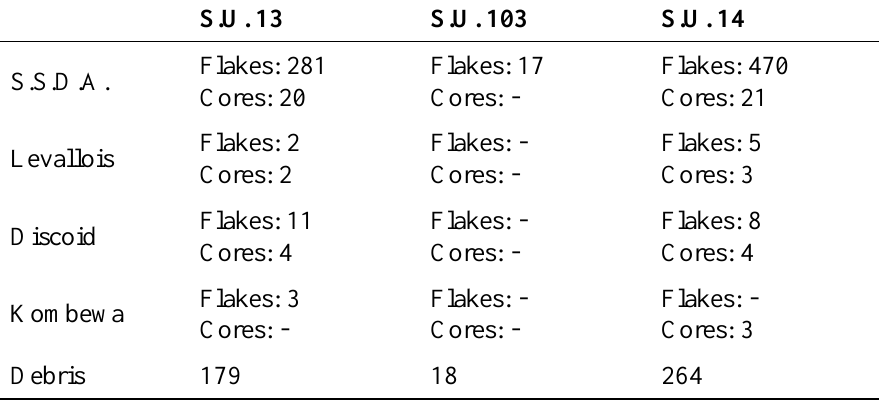
Table 1. Ciota Ciara cave. Technological analysis performed for S.U. 13, 103 and 14.